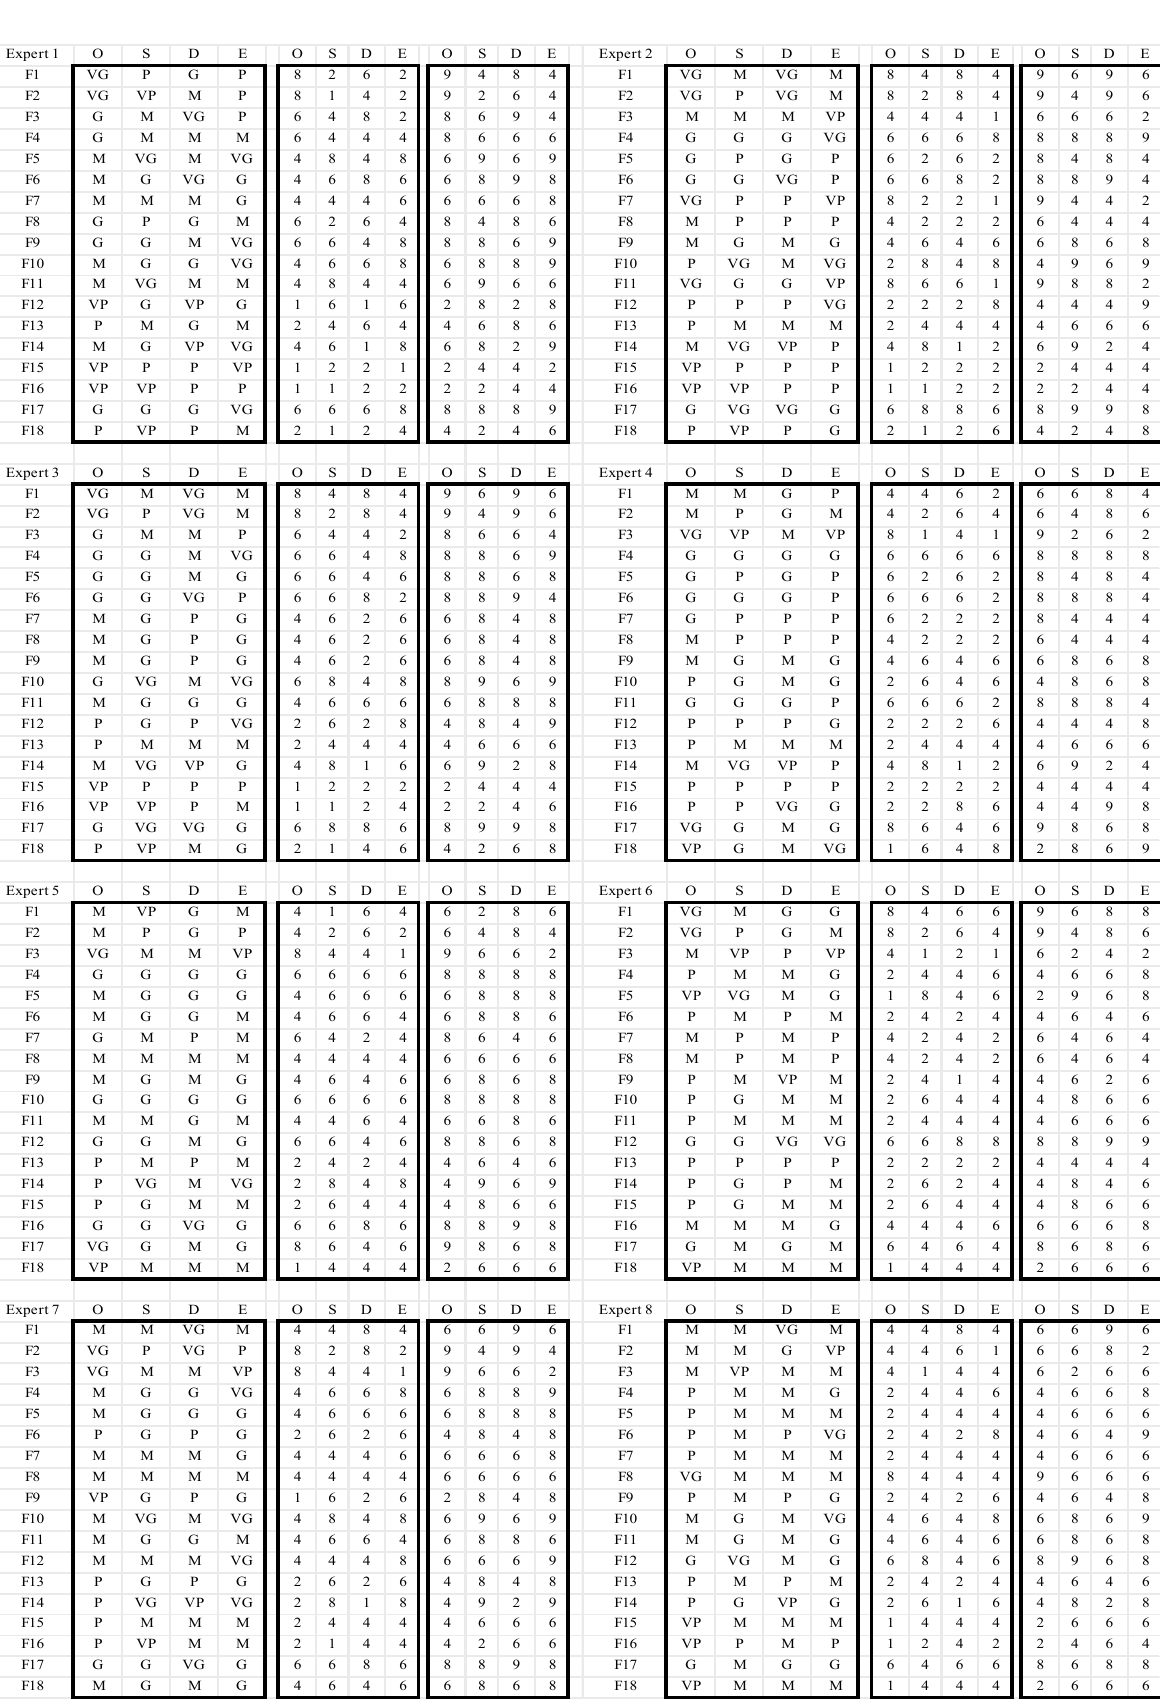
Figure A1. The data of the evaluation matrix collected by eight experts.